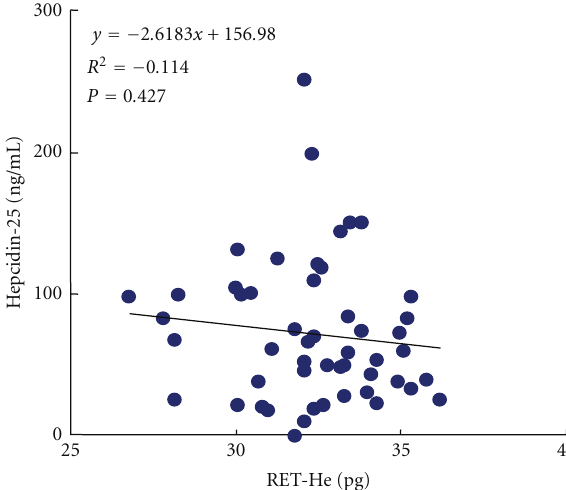
Figure 4: Correlation between serum hepcidin-25 levels and RET- He (reticulocyte hemoglobin